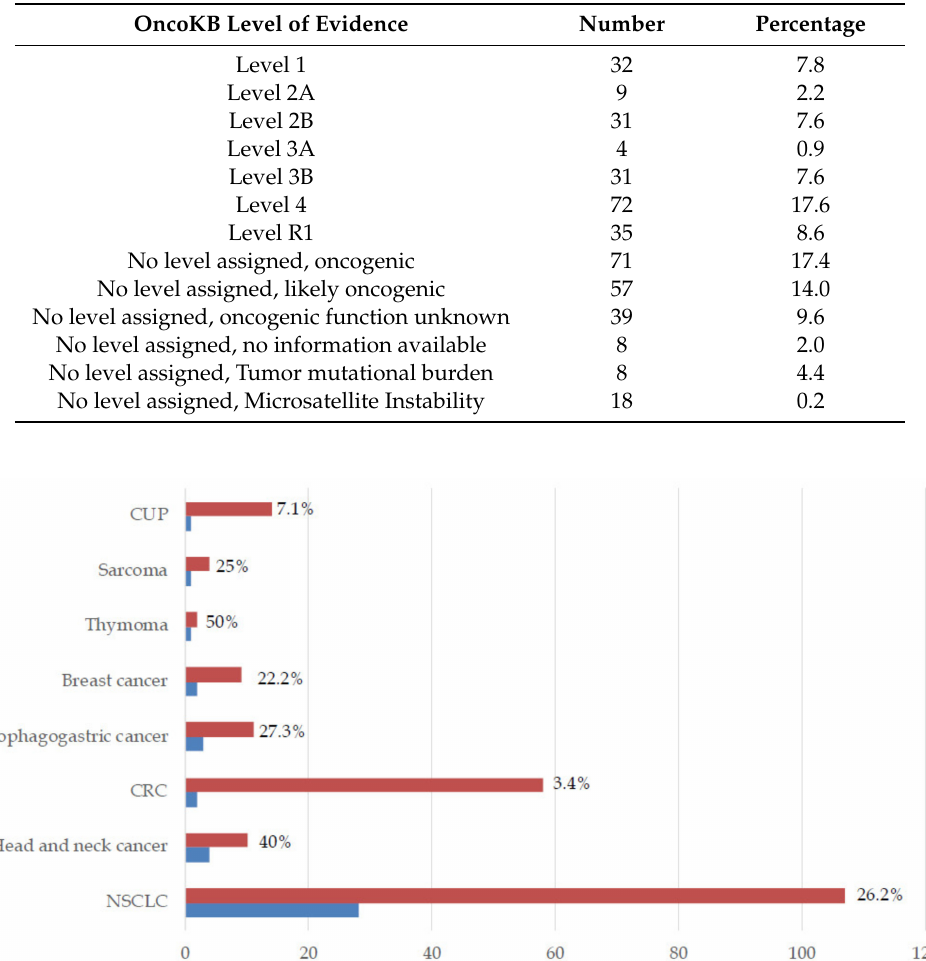
Table 2. Classification of actionable molecular alterations according to OncoKB levels of evidence (of note, some alterations had more than one level of evidence assigned depending on the alteration and specific therapy involved).